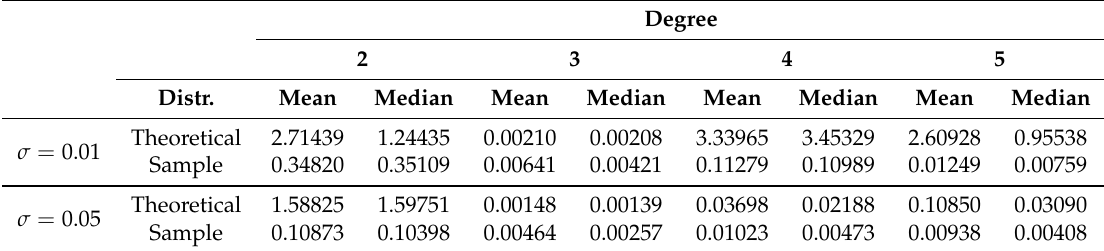
Table 3. Example 1. Means and medians of the resistor-average distances.